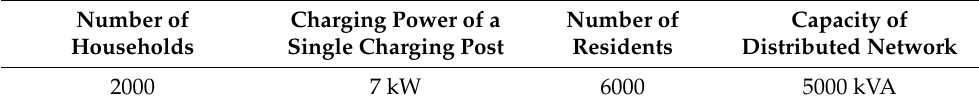
Table 1. Relevant parameters of the RA.